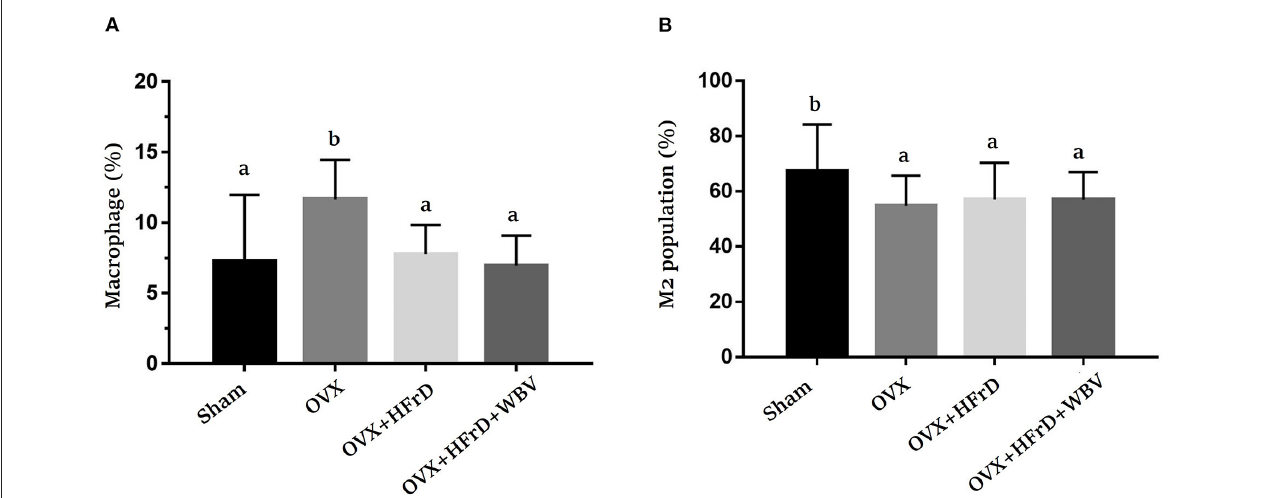
FIGURE 5 | The effects of whole-body vibration (WBV) combined with a high-fructose diet (HFrD) on ovariectomized (OVX) mice in terms of macrophage populations. Macrophages were extracted from the adipose tissue and double-stained with markers (CD11b and F4/80) to identify the total macrophages (A) and double-stained with markers (CD11b and CD206) to identify M2 macrophages (B) . The data are presented as means ± SD. Different superscript letters indicate significant differences ( P < 0.05), as indicated by a one-way analysis of variance.